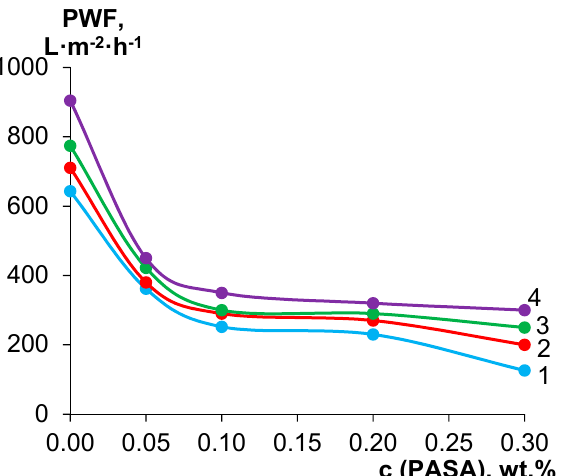
Figure 10. Dependence of pure water flux (PWF; measured at trans-membrane pressure of 1 bar) on PASA concentration in the coagulation bath at different coagulation bath temperatures, T, °C: 1—25; 2—40; 3—60; 4—70.